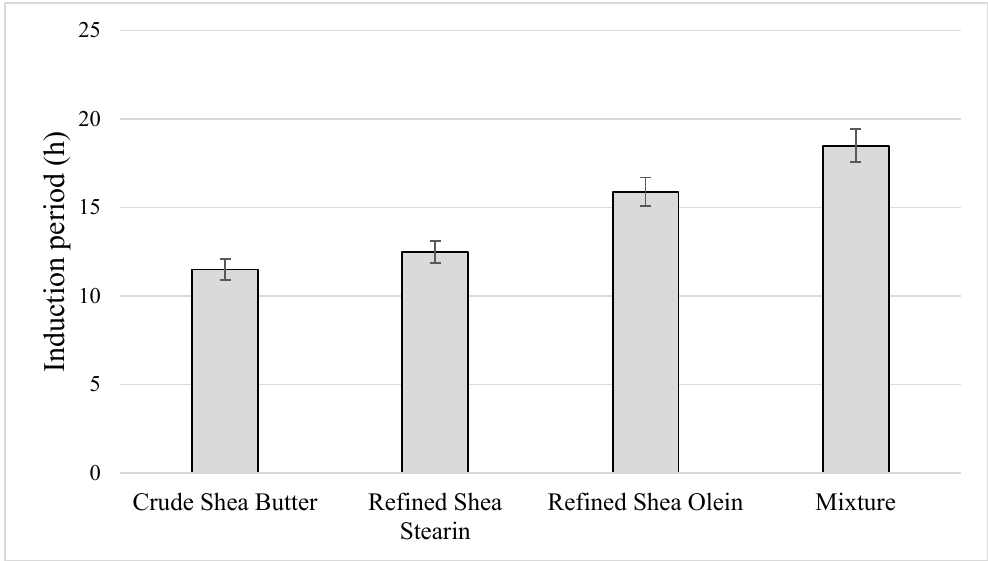
Figure 1. Induction period (h) of crude shea butter, refined shea stearin, refined shea olein and a mixture of olein:stearin 1:1 w / w .